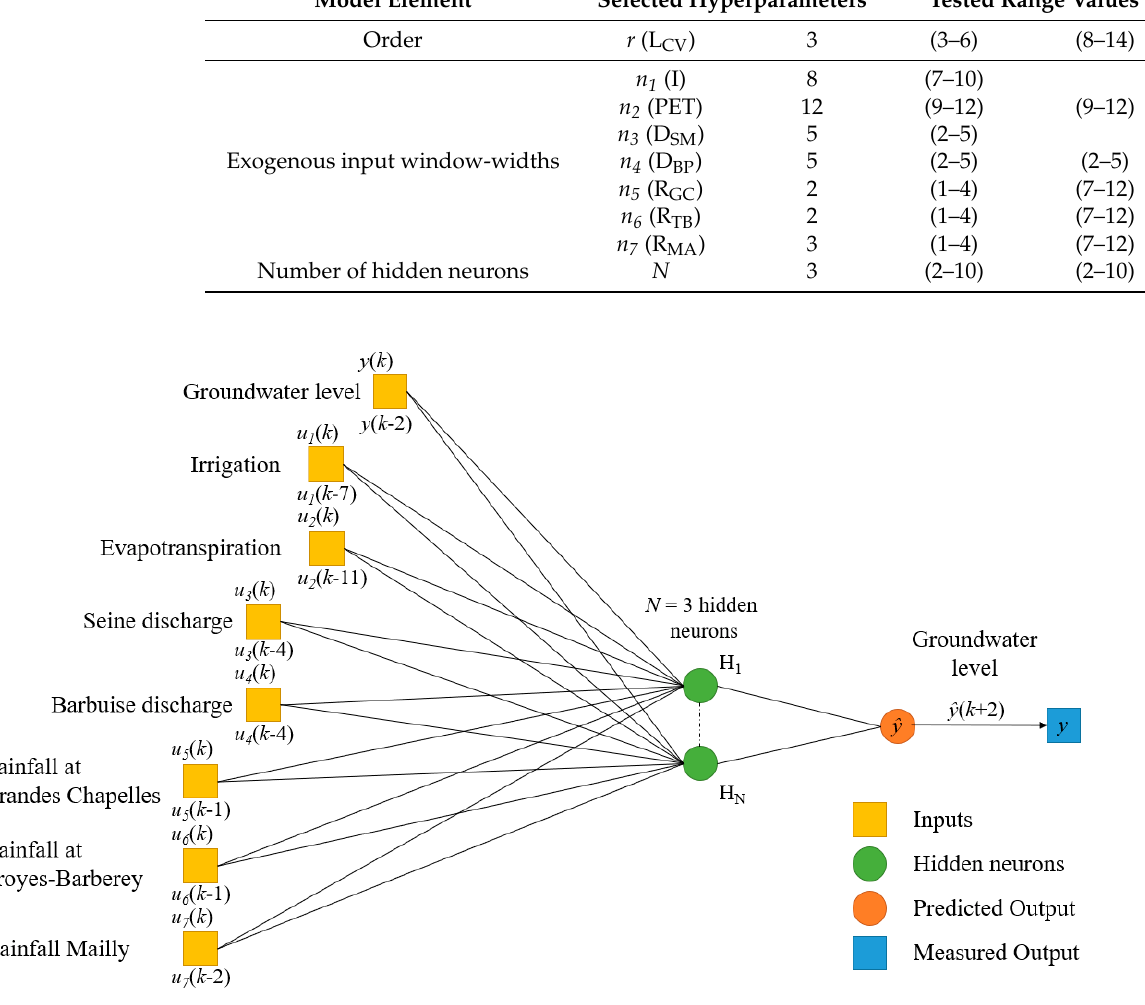
Figure 4. Selected architecture.